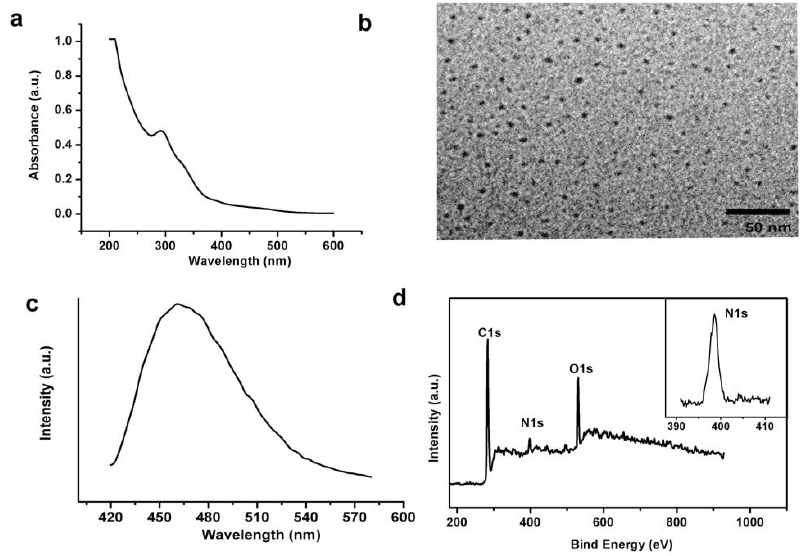
Figure 2. ( a ) UV-vis absorption spectrum of N-doped CDs; ( b ) The typical TEM image of the N-doped CDs; ( c ) PL spectrum of the N-doped CDs with excitation at 280 nm; ( d ) XPS full scan spectrum of the N-doped CDs, inset is XPS N 1s spectrum of the N-doped CDs.